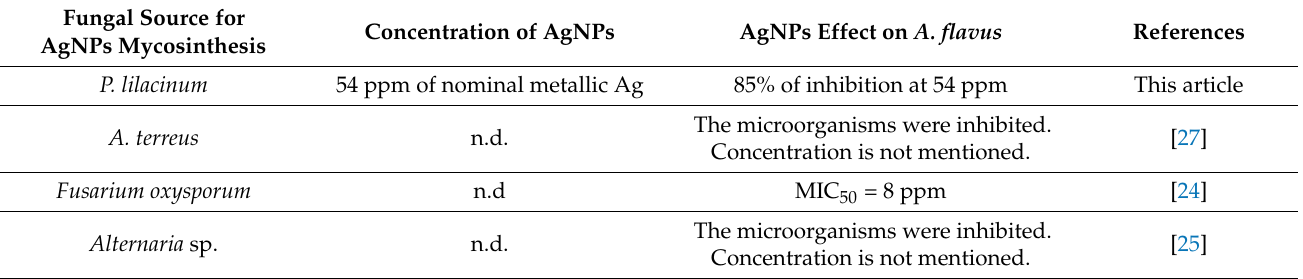
Table 2. Synthesis of AgNPs from fungi extract and their effect on A. flavus . Fungal Source